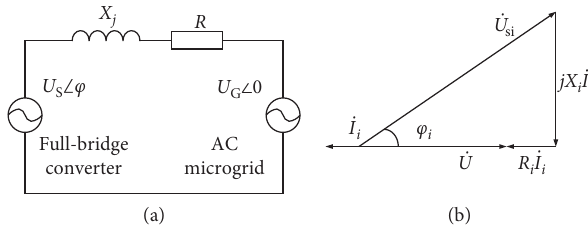
Figure 2: Equivalent power model. (a) Equivalent full-bridge transformation model. (b) Voltage vector analysis.